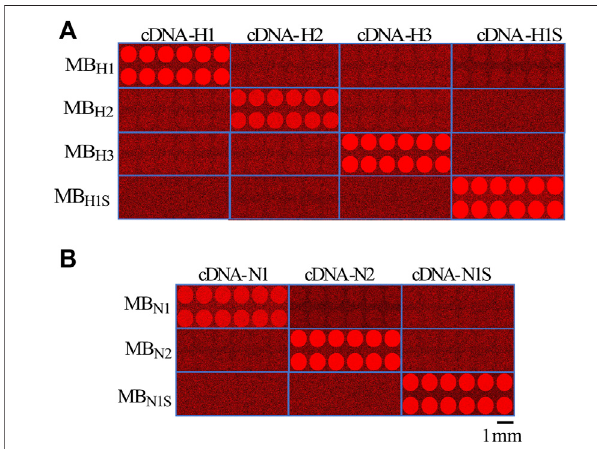
FIGURE 5 | Images from microarrays illustrating the selectivity of the MBs to identify their respective targets. (A) , images obtained from the microarrays illustrate the selectivity of the MBs to identify their speci fi c target cDNA for hemagglutinin H1, H2, and H3 from human and swine H1s (each sample was printed 12 times to ensure reproducibility of the array. Microarrayswereacquiredseparatelyforeachgeneandthencombinedintoa single image as shown in A. (B) , similar procedure to the previous study in A, but in this case using the cDNA and MBs for the neuraminidase N1 and N2 from human and swine N1s. All microarray images were color mapped to red to enhance the signal to the naked eye. The spatial scale shows 1 mm.